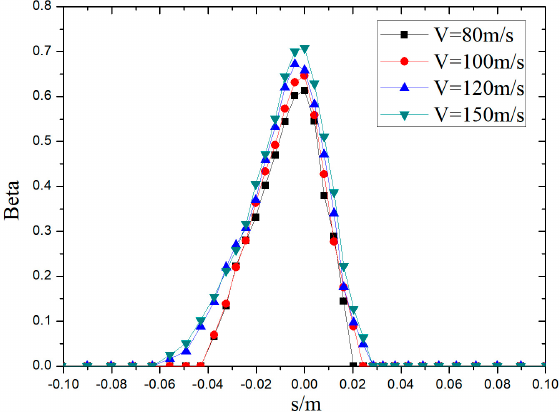
Figure 12. Comparison of the ice crystal collection coefficients for different diameters.